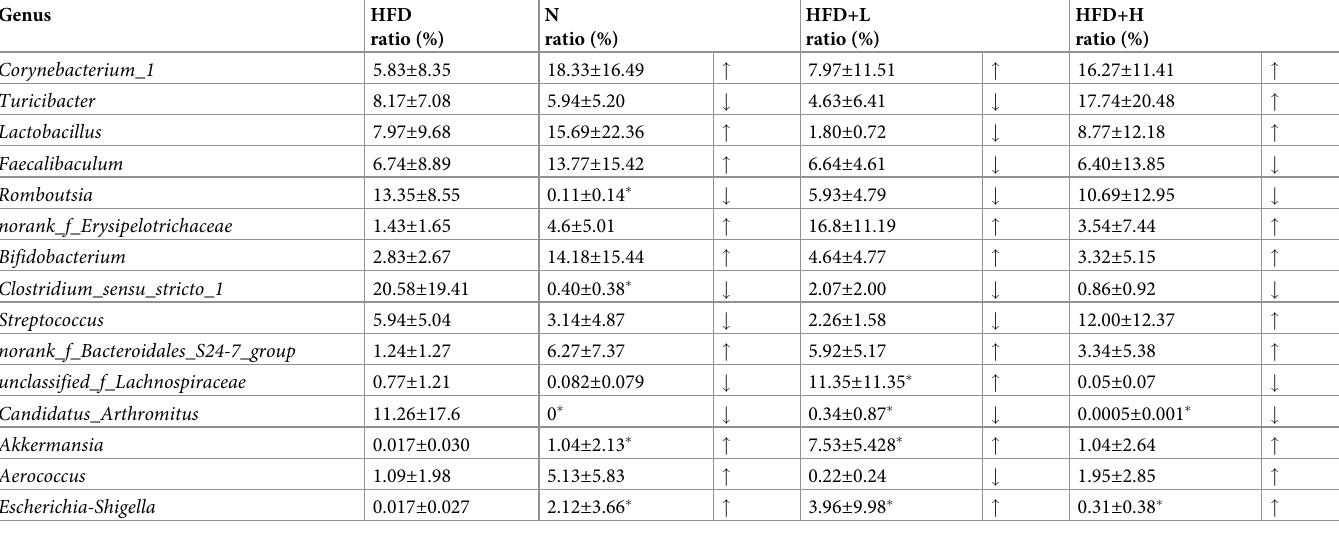
Table 1. The changes of the top fifteen genera by the treatment of